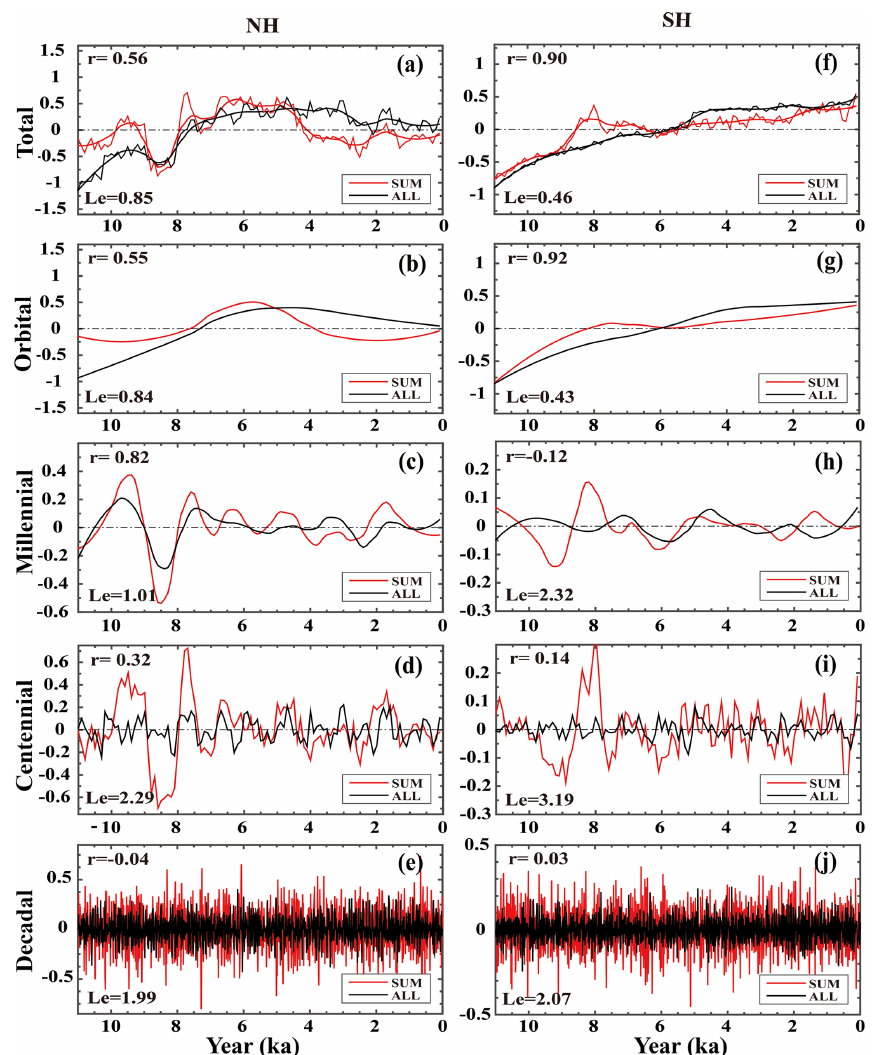
Figure 2. The surface temperature time series derived from the ALL run (black) and the SUM (red). Panels (a–e) are similar to Fig. 1a–e but for NH, and (f–j) are similar to Fig. 1a–e but for SH. The x axis is year (ka, 0 is 1950CE), and the y axis is the temperature anomaly ( ◦ C, relative to